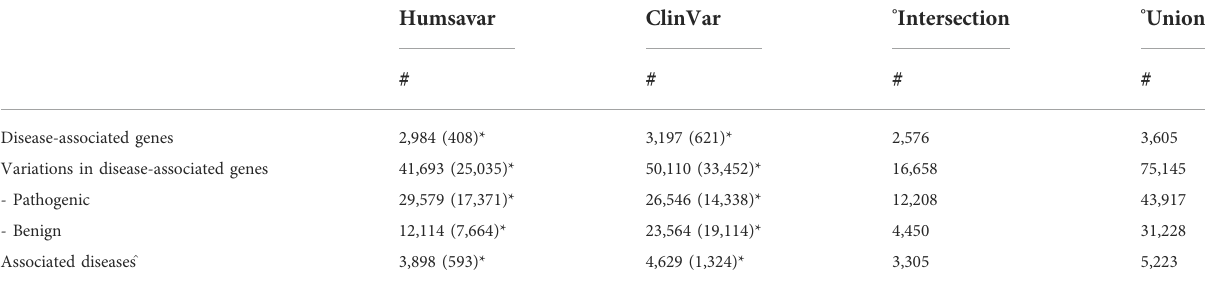
TABLE 1 General description of the Union